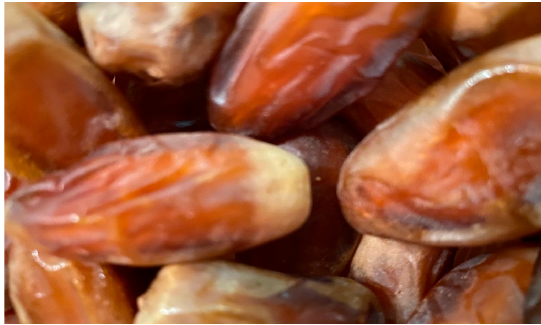
Figure 9. Sample of Al-bowytha dates.